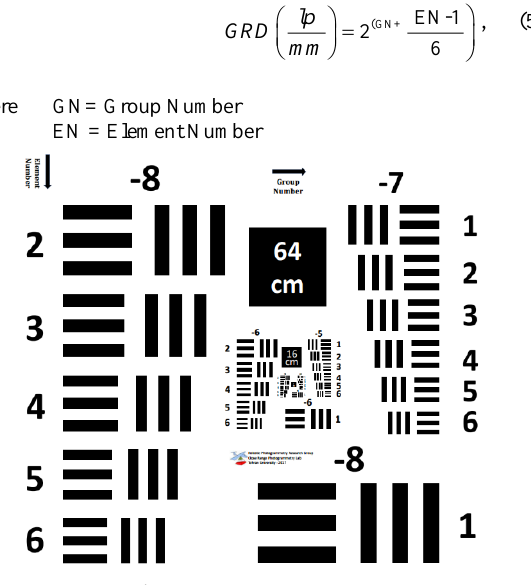
Figure 2. USAF test